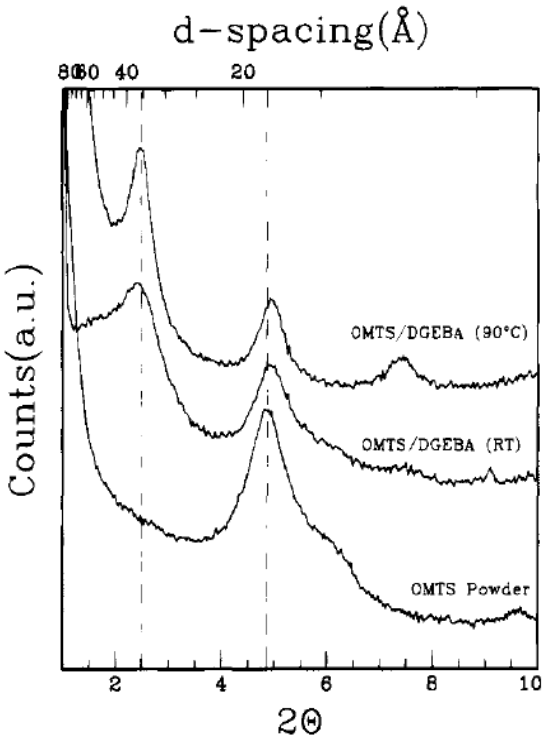
Figure 20. X-ray diffractograms of the modified filler and the mixture of epoxy prepolymer with filler at room temperature and at 90 °C. Reproduced from reference [86] with permission from The American Chemical